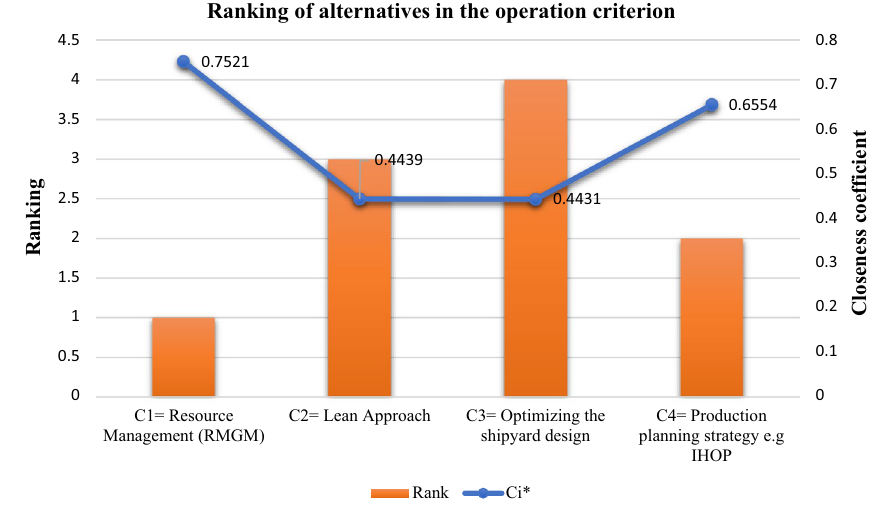
Fig. 12 Ranking of alternatives in the operation